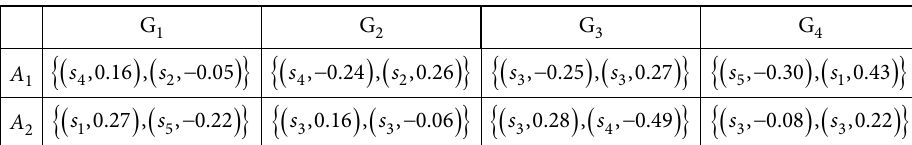
Table 8. Collective assessing matrix with